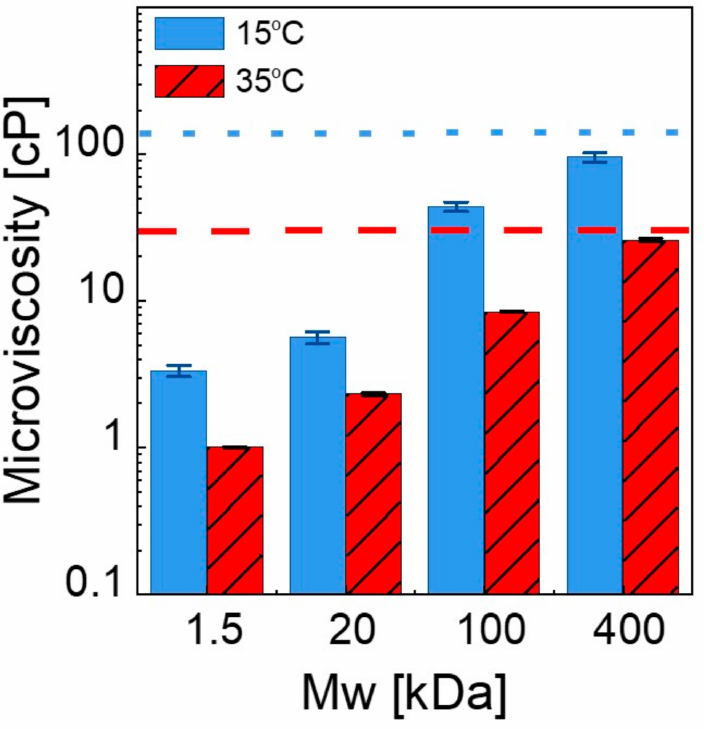
Figure 7. Comparison of microviscosity of the lipid bilayers in 2 wt% PEG solutions with different molecular weights at 15 ◦ C and 35 ◦ C. Short dotted lines and dashed lines indicate the microviscosity of the neat liposomes at 15 ◦ C and 35 ◦ C, respectively. The data are averaged over three separate measurements, and the error bars represent one standard